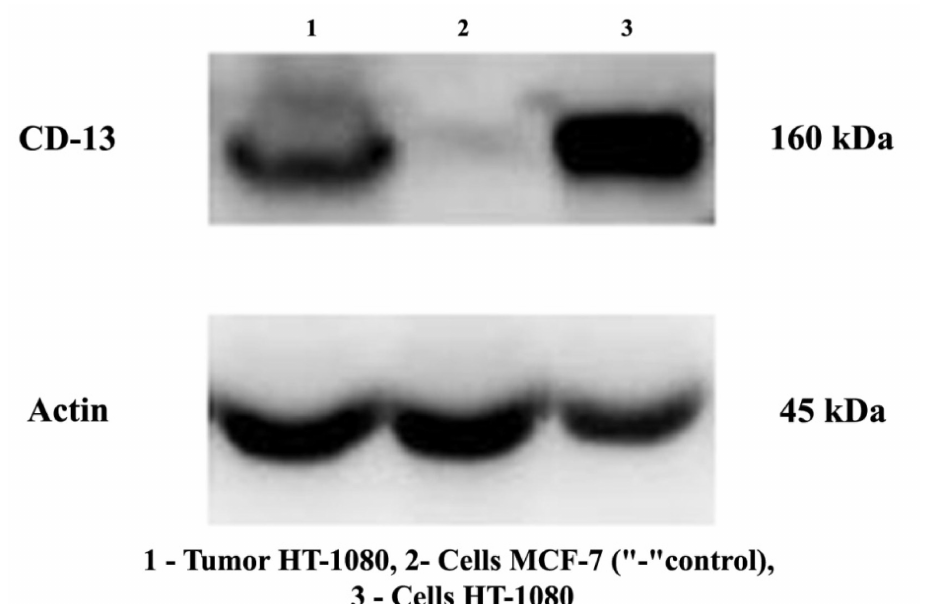
Figure 3. CD13 expression in HT-1080 xenograft tumor, HT-1080 and MCF-7 cell lines (negative control) by Western